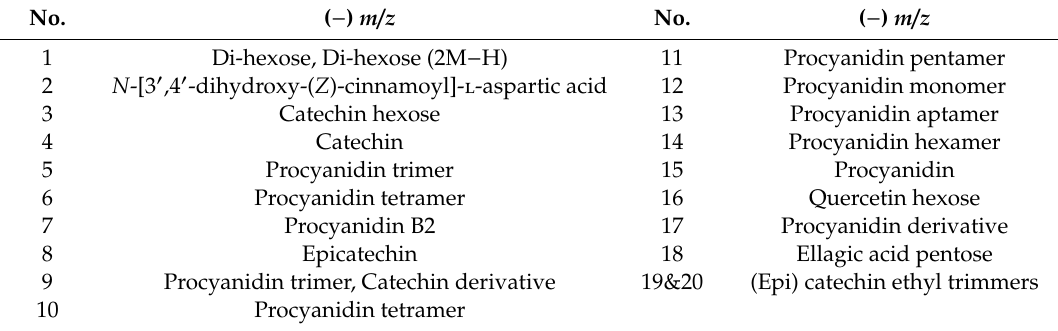
Table 1. Phenolic molecules identified from the cocoa extract samples analyzed by chromatographic mass spectra in negative ion